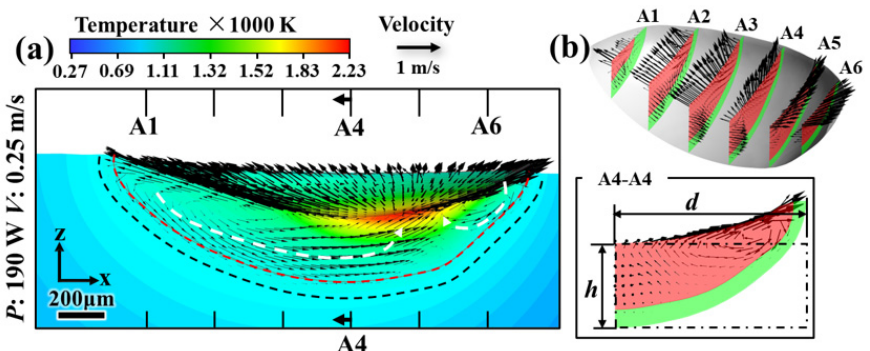
Figure 7. Analysis of convection diffusion by Peclet number Pe: ( a ) Temperature and velocity field of molten pool with laser power of 190 W and scanning rate of 0.25 m/s, and ( b ) the measuring sketch of characteristic length L.